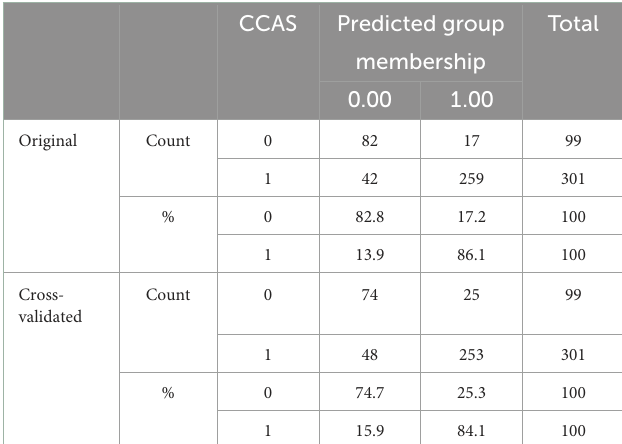
TABLE 6 Classification of results for the discriminant function.